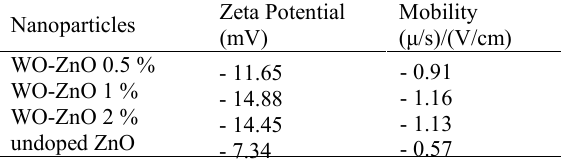
Table 1. Zeta potential of nanoparticles